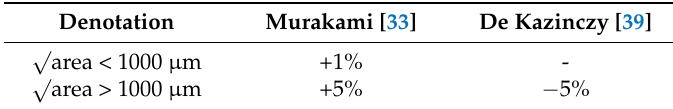
Table 6. Mean deviation of analytical fatigue models compared to experiments.